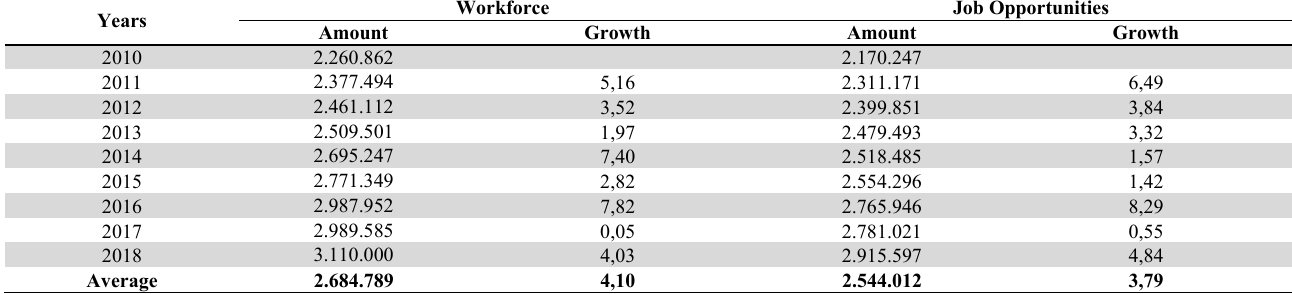
Comparison between Labor Force and Employment Opportunities in Riau Province in 2010-2017